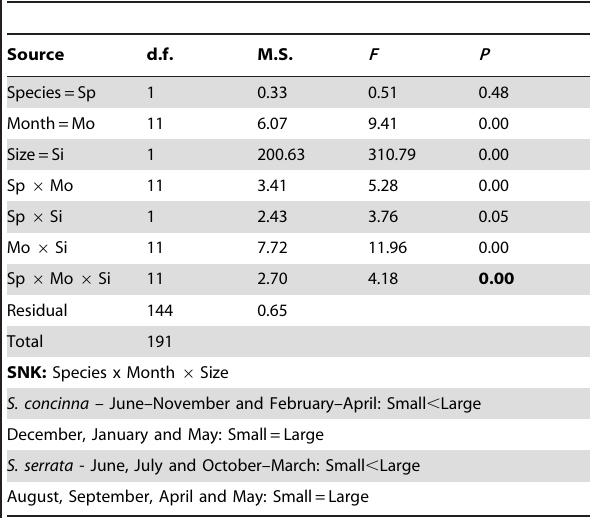
Table 6. Analysis of variance comparing within patch variability of Siphonaria concinna and S. serrata over 12 months in the Eastern Cape